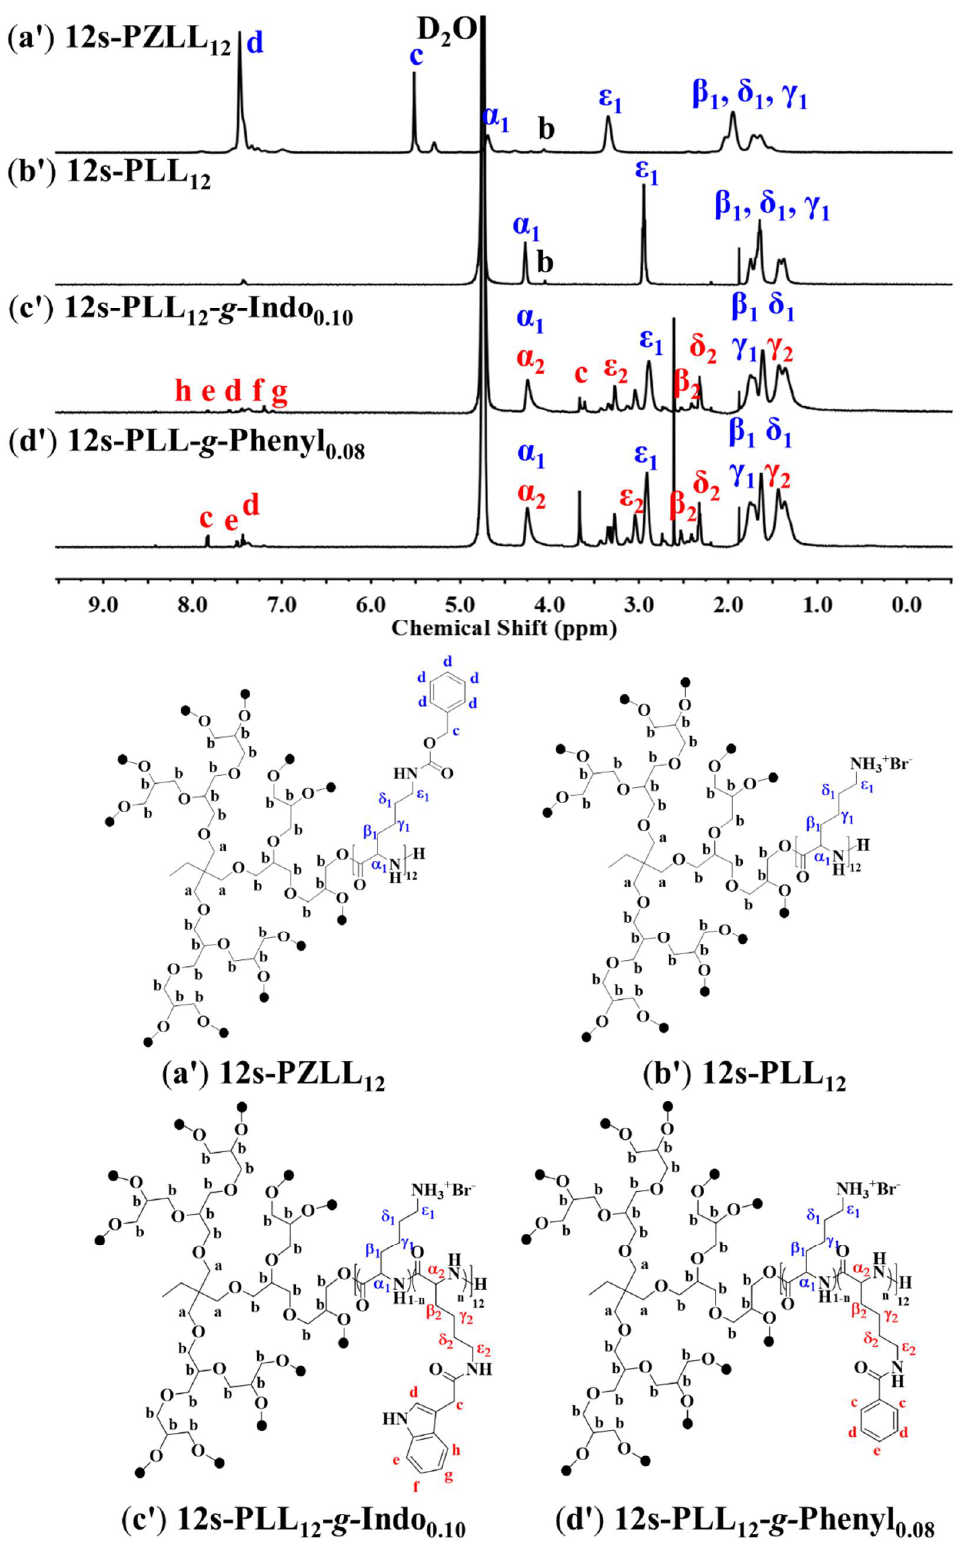
Figure 1. 1 H NMR spectra of ( a’ ) 12-armed poly(Z- L -lysine) 12 (12s-PZLL 12 ) in TFA- d 1 , ( b’ ) 12- armed poly( L -lysine) 12 (12s-PLL 12 ) in D 2 O, ( c’ ) 12-armed poly( L -lysine) 12 - graft -indole 0.10 (12s-PLL 12 - g -Indo 0.10 ) in D 2 O, and ( d’ ) 12-armed poly( L -lysine) 12 - graft -phenyl 0.08 (12s-PLL 12 - g -Phenyl 0.08 ) in D 2 O. The symbols were used to represent the different